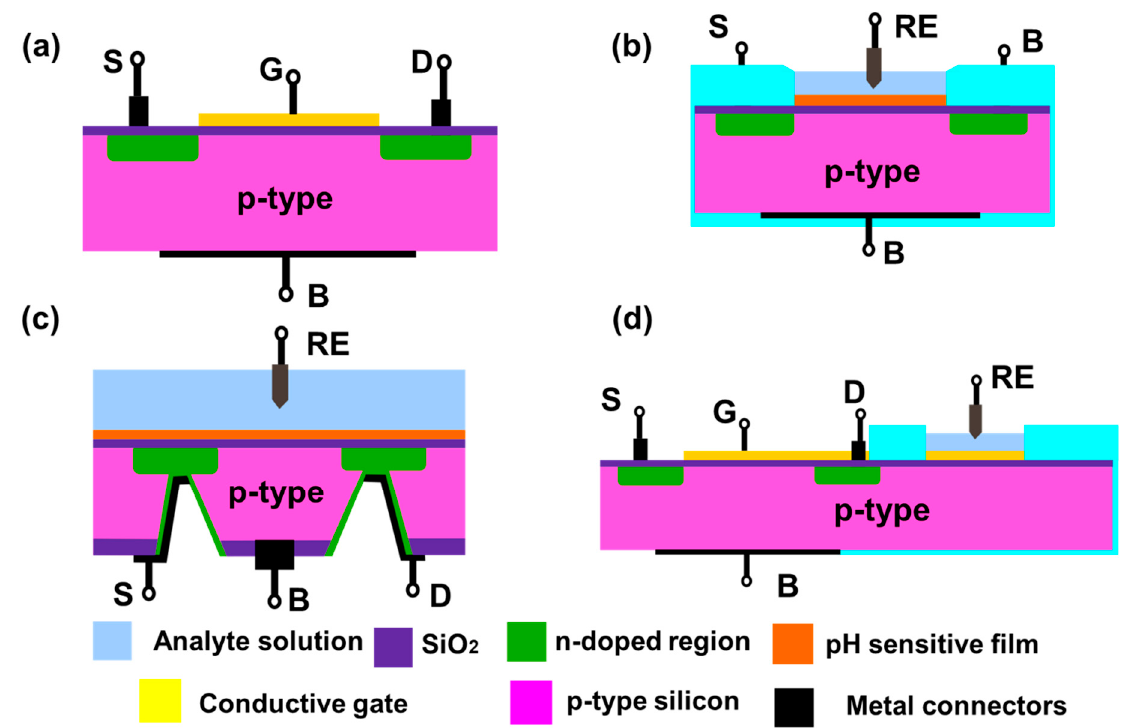
Figure 4. Schematics of a ( a ) MOSFET with p-type silicon as a base substrate (pink) and n-doped source and drain region (green) ( b ) ISFET with a pH sensitive film (orange) ( c ) Back gated FET with analyte solution and RE on the top side and all the terminal connections are done from the back side ( d ) Extended gate FET with a regular MOSFET and an extended sensing region connected with gate terminal of the MOSFET. S, G, D and B are source, drain, gate and base substrate terminals (all shown in black). RE is the reference electrode.